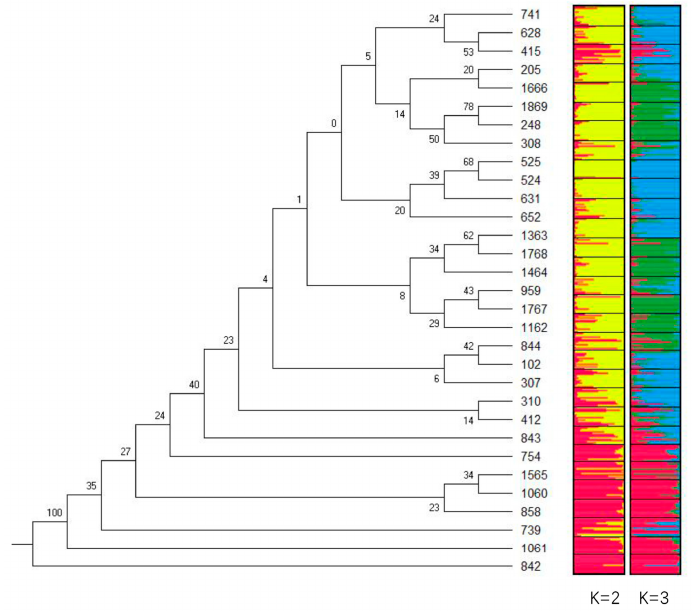
Figure 4. A consensus tree of the genetic relationships and genetic structure among 31 populations of M. azedarach . (Note: the numbers at the forks are the bootstrap probabilities estimated from 1000 bootstrap samples in the neighbor-joining method.)